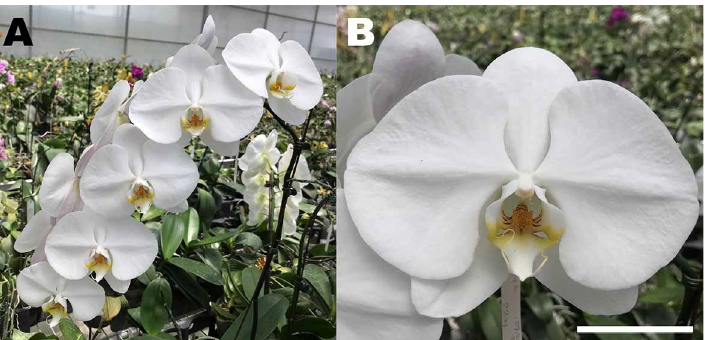
Figure 2. Flower spike ( A ) and individual flower ( B ) in elite tetraploid hybrid Phalaenopsis Sogo Yukidian ‘V3’ (2n = 4x = 76), the standard white hybrid most sold in Taiwan. This extremely stable meiotic hybrid was derived from Phalaenopsis Doris, an old interspecific hybrid synthesized from crossing Phalaenopsis amabilis , Phalaenopsis rimestadiana and Phalaenopsis aphrodite . The spikes carry multiple flowers all evenly spaced, and the flowers themselves are symmetrical, large, flat, and long lived. Scale bar: 2.5 cm. Photos taken by F.C. Chen in Pingtung County, 2022. Work in Brassica allotriploids (AAC genome, 2 n = 3x = 29) derived from the species